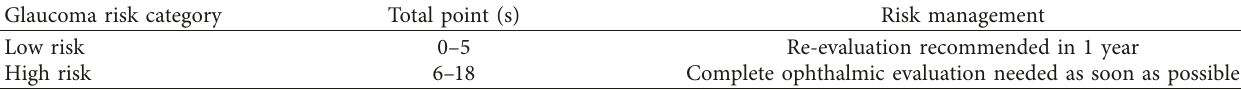
Table 2: The Laroche glaucoma calculator: determining glaucoma risk and